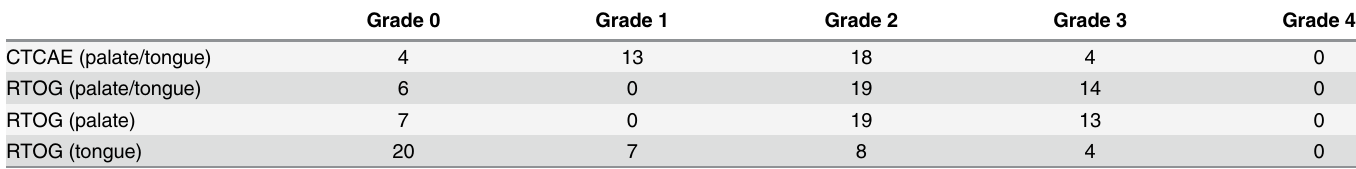
Table 2. Locations and stages of acute radiation mucositis in patients with head and neck tumors treated via carbon ion